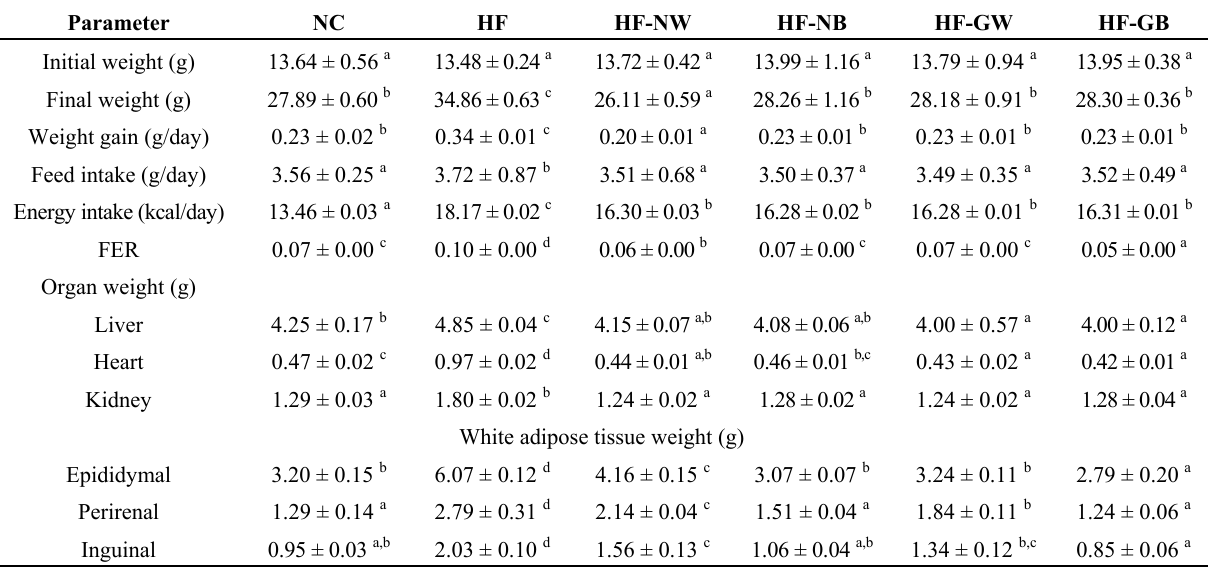
Table 3. Body weight gain and weights of organs and adipose tissues in mice fed with high fat diet supplemented with instant cooked